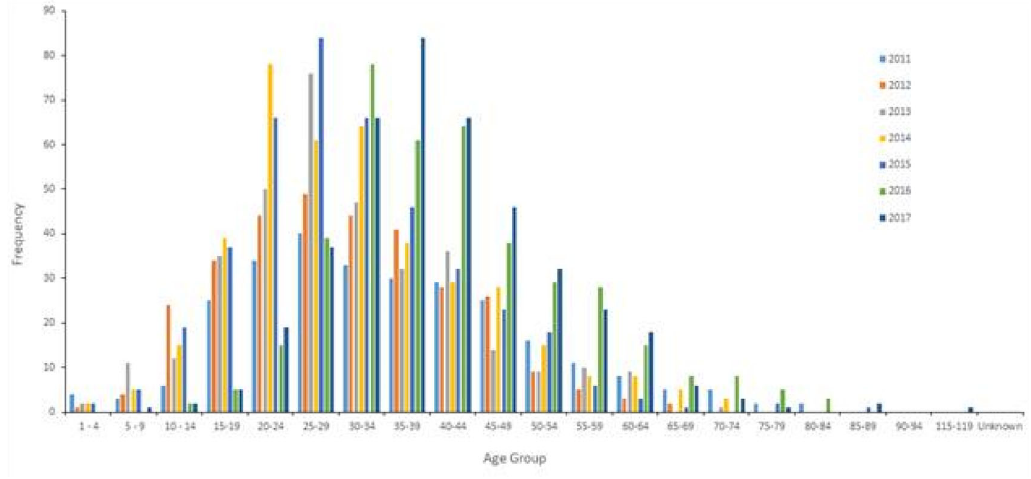
Figure 6B. Graphical representation of the age distribution of thyroid cancer in UAE from 2011 to